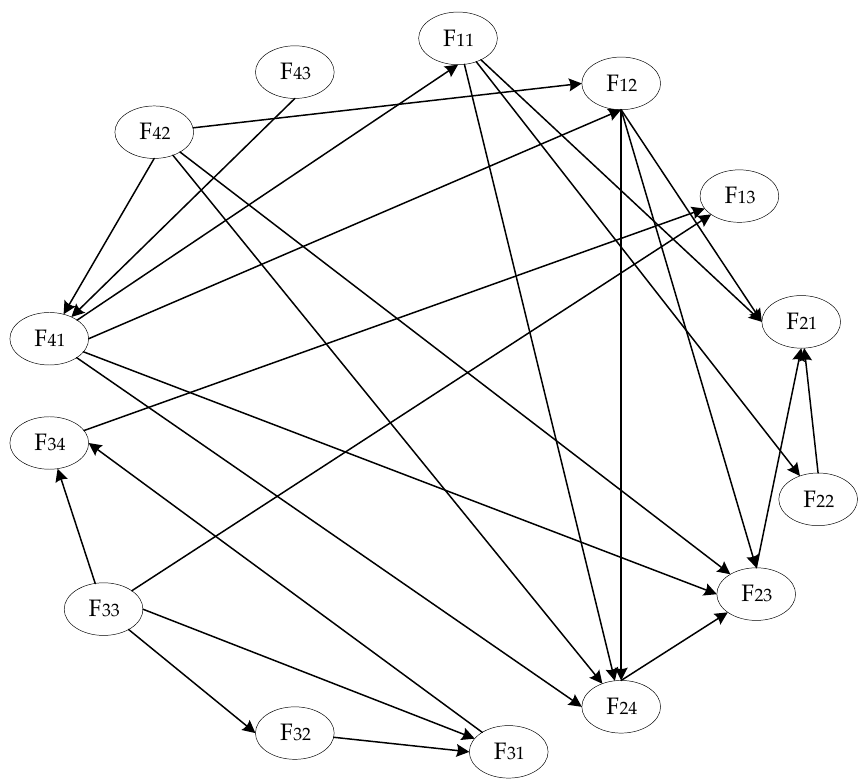
Figure 6. The structure of the Bayesian network (BN).